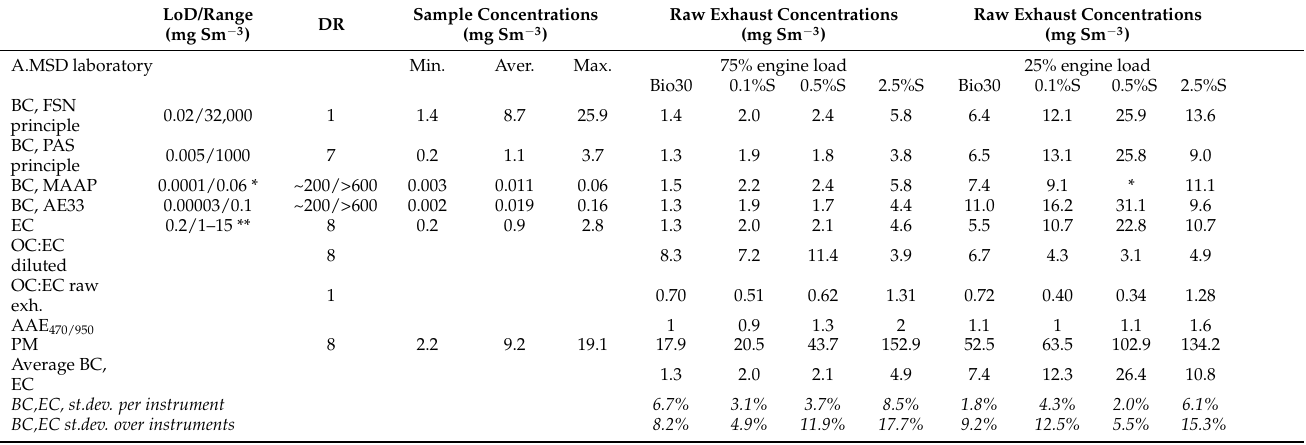
Table A1. PM, BC, and EC concentrations and ratios of OC/EC and AAE470/950 at low and high loads in campaigns A and B and over cycle in campaign